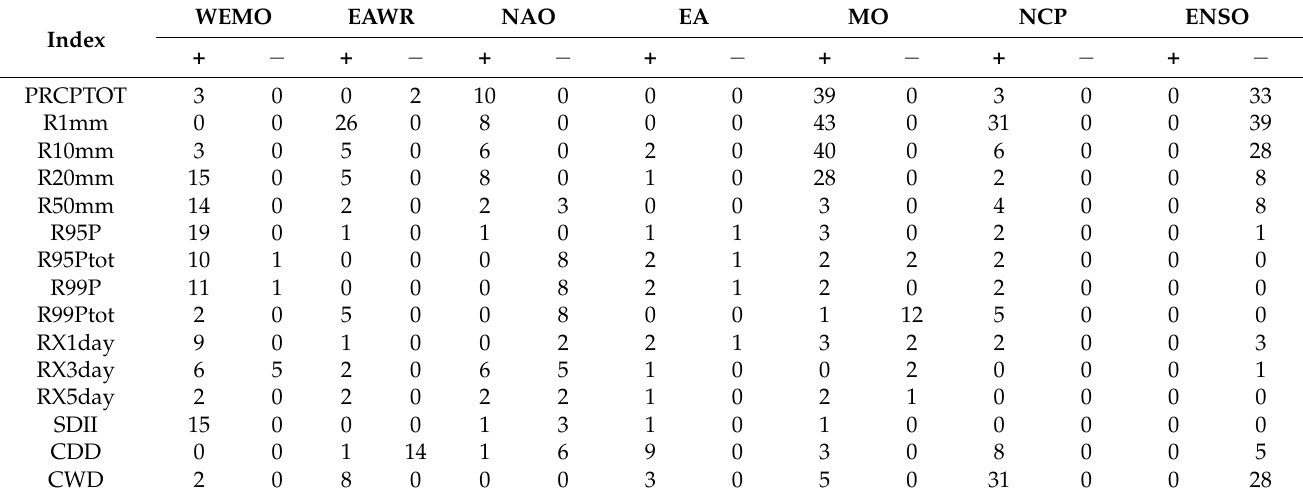
Table 4. Number of stations with significant positive or negative correlations between extreme precipitation and teleconnection indices at an annual scale. Only significant results at the 95% confidence level are